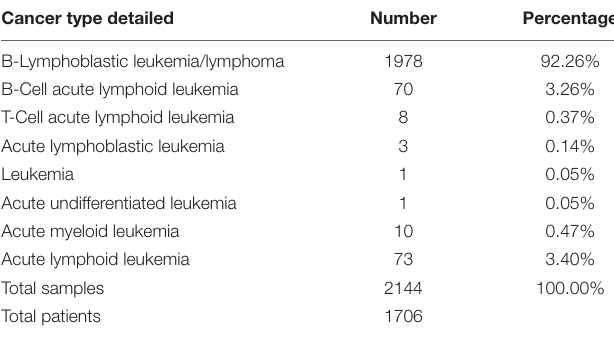
TABLE 1A | Cancer Type Detailed and numbers for lymphoid cancers and specifically the studies with lymphoblastic and Lymphoid leukemia [Acute Lymphoblastic Leukemia (St Jude, Nat Genet 2015), Acute Lymphoblastic Leukemia (St Jude, Nat Genet 2016), and Pediatric Acute Lymphoid Leukemia - Phase II (TARGET, 2018)] used in our study.